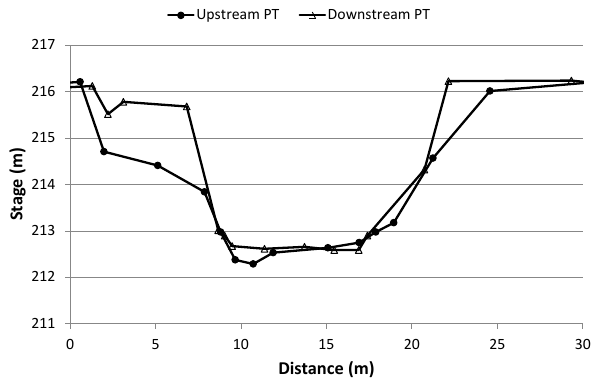
Figure 2. Surveyed cross sections at upstream PT and downstream PT locations. The horizontal axis represents the distance from the left bank when looking upstream and the vertical axis represents stages in the NAVD